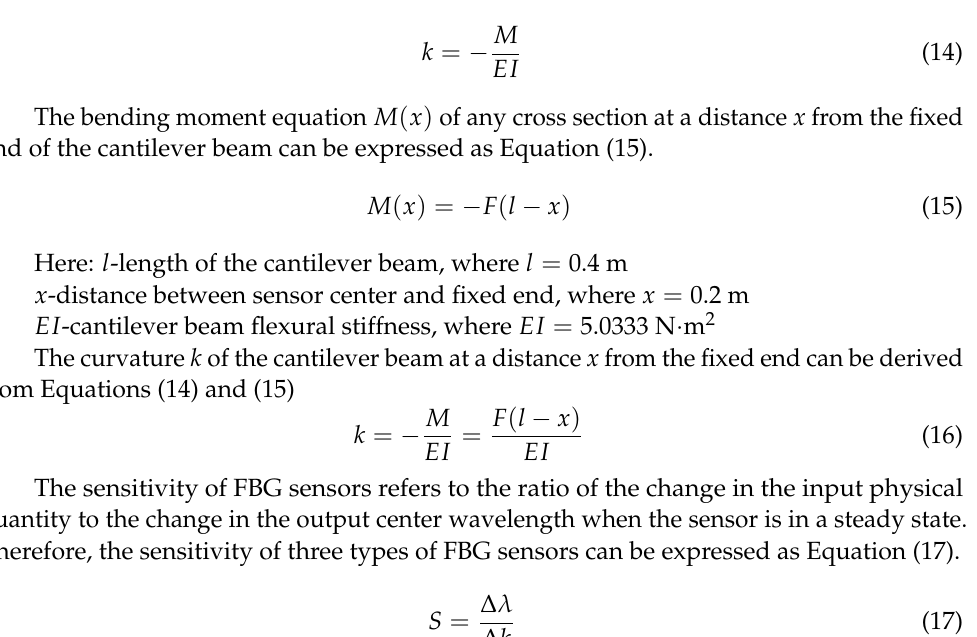
Table 9. Sensitivity of the three kinds of FBG sensors.